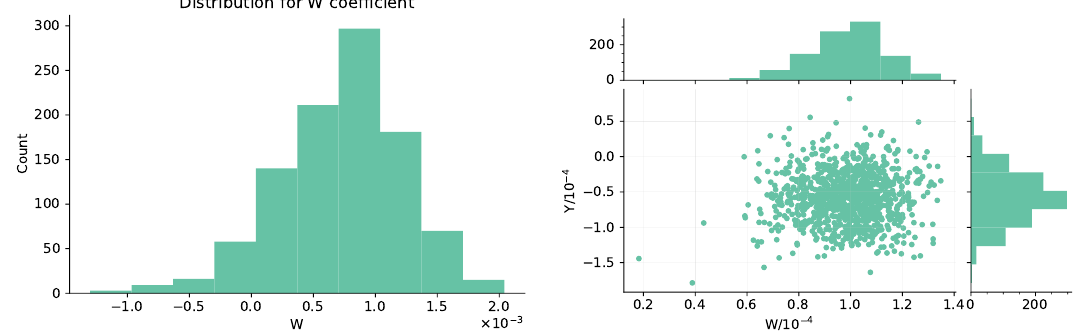
Figure 13 . Result of the closure testing framework for our methodology. Left: histogram for the distribution of the W parameter when the input data has been modified by setting W = 1 × 10 − 3 . Right: distribution of ( W, Y ) when fitting to data that has been modified by setting ( W, Y ) = (1 , − 1) × 10 − 4 . The upper and right panels show the histograms for the distribution of the best fit values in their respective